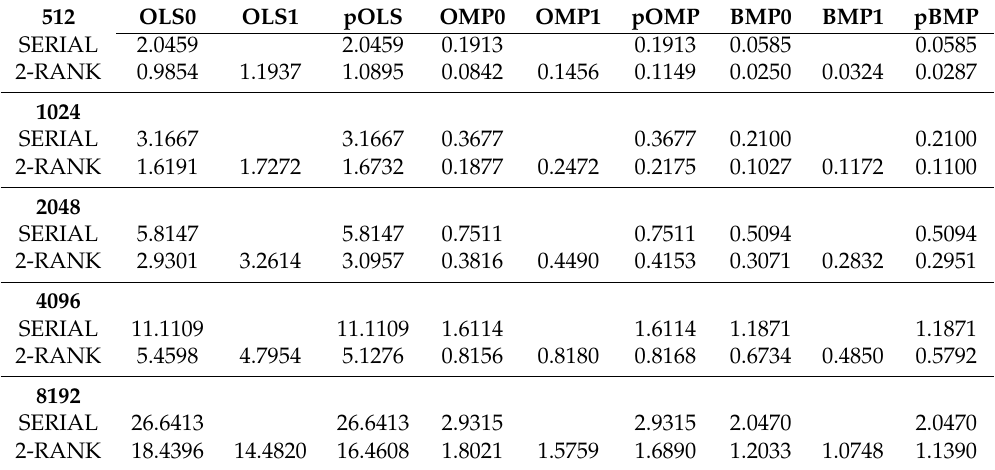
Table 3. Time performance of MIMO matching pursuit algorithms. BMP, basic matching pursuit.